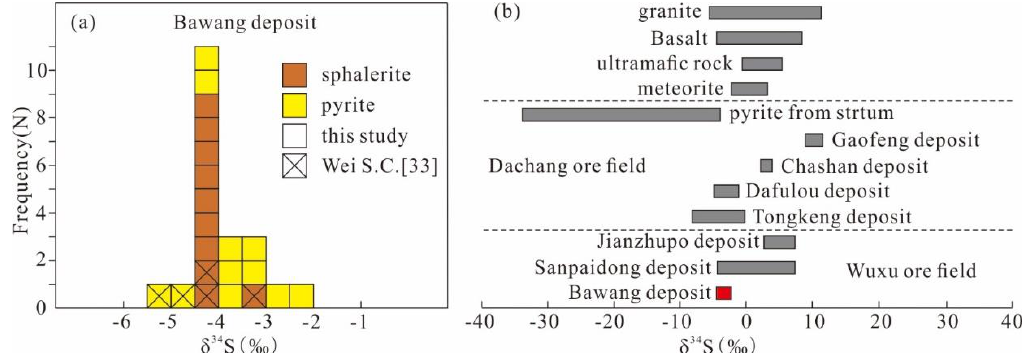
Figure 9. Histogram of sulfur isotopes of sulfides from the Bawang deposit ( a ); sulfur isotopic signatures of different deposits in the Nandan-Hechi metallogenic belt igneous rocks ( b ) [24,30,31,39,74–77].